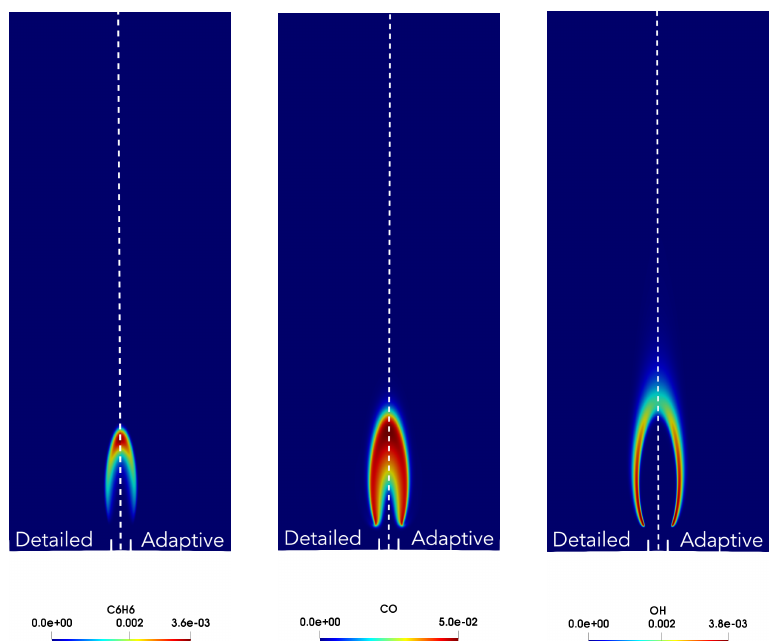
Figure 10. Comparison of temperature maps (in Kelvin) for detailed (left part of each contour) and adaptive (right part of each contour) unsteady simulations obtained with a sinusoidal perturbation in the fuel velocity profile ( f = 10 Hz and A = 0.25), with reduced mechanisms obtained via LPCA pre-partitioning and (cid:101) DRGEP = 0.005, for several timesteps: ( a ). t = 0.01 s; ( b ). t = 0.05 s; ( c ). t = 0.09 s; ( d ). t = 0.12 s.